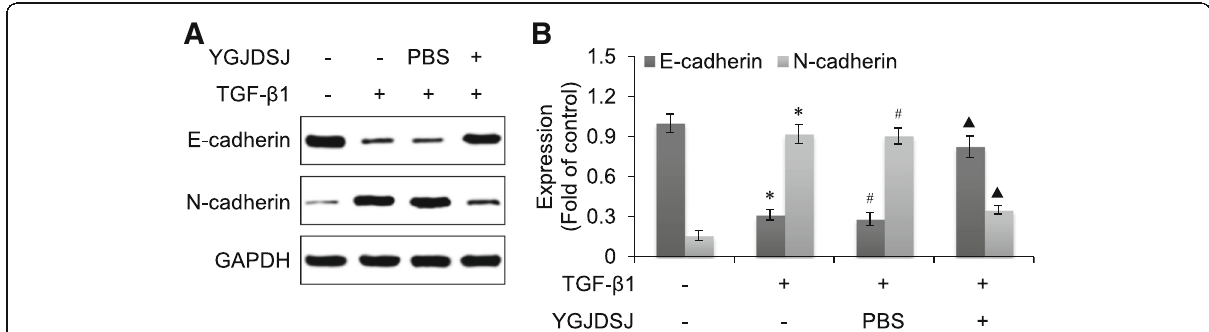
Fig. 2 Effects of YGJDSJ on TGF- β 1-induced expression change of EMT marker proteins. a , Bel-7402 cells were treated with TGF- β 1 and YGJDSJ or PBS for 48 h, and subjected to western blotting using indicated antibodies. b , protein expression was quantified by the Quantity One software. * p < 0.01, versus control group; # p > 0.05, versus TGF- β 1 group; ▲ p < 0.01, versus PBS